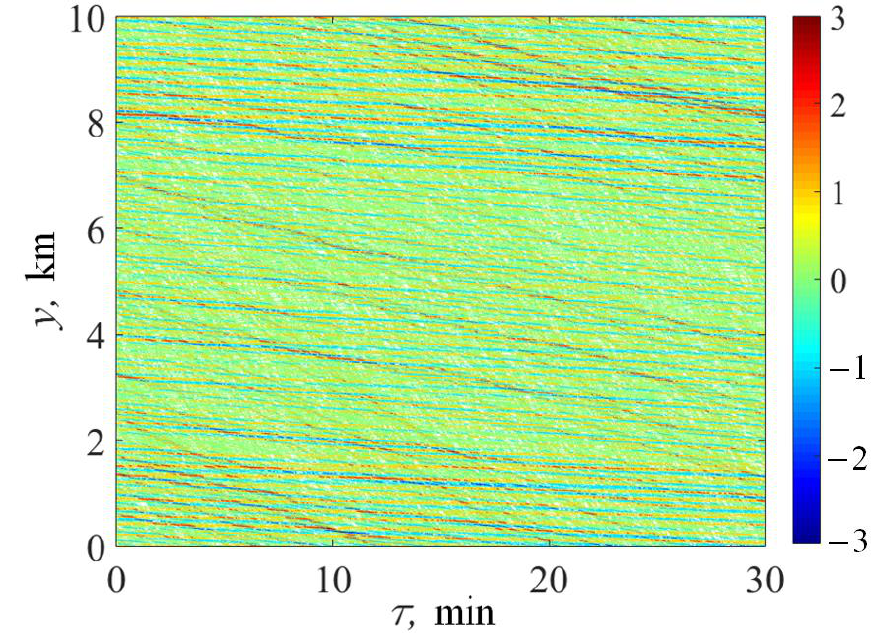
Figure 4. Trajectory pattern, presented in time – space plane.